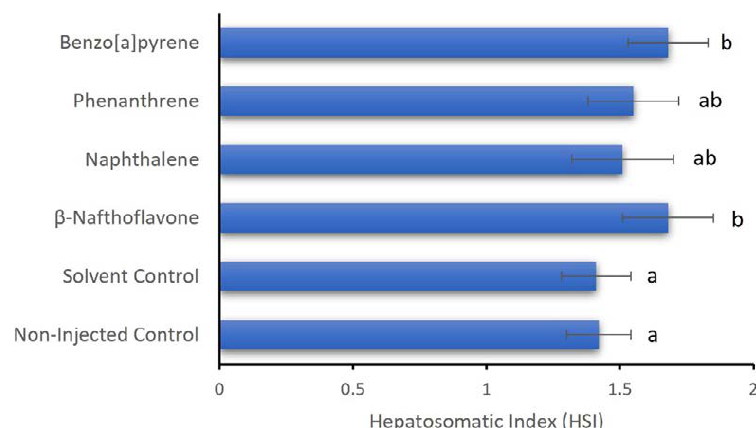
Fig. 2: Hepatosomatic index in Aequidens metae exposed to PAH during 72 h. Bars shown the mean ± SE (n = 5). ab Bars with different letters shown statistically significant differences (Tukey-Test, p<0.05) between treatments.